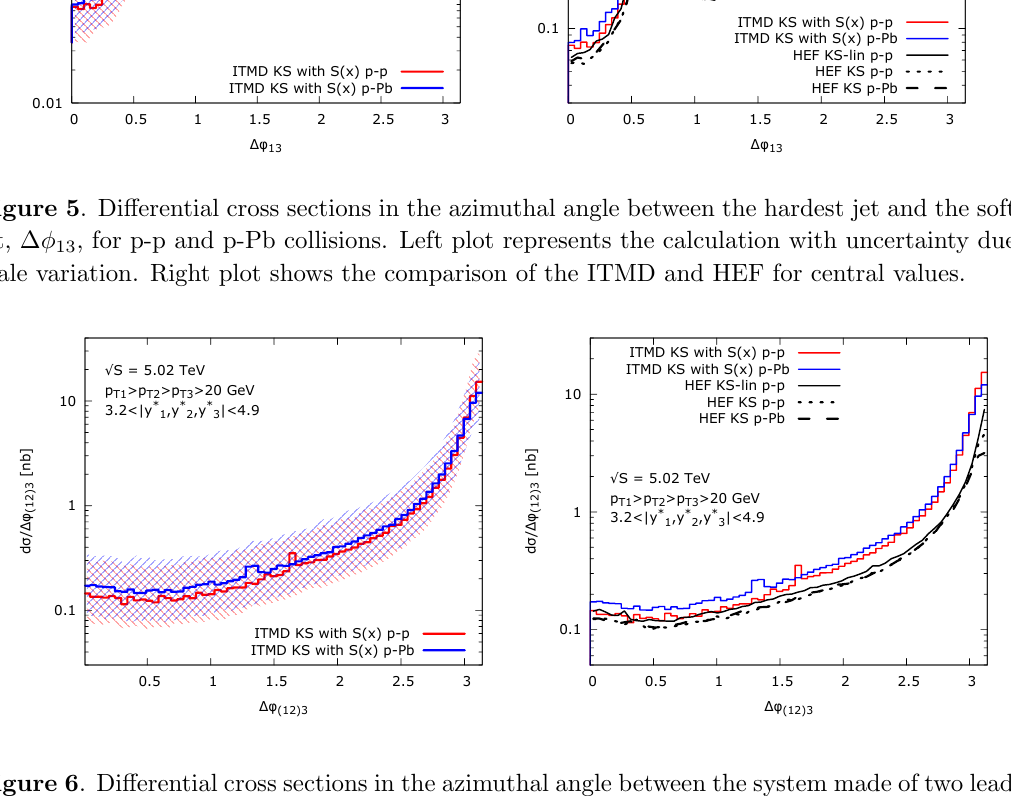
Figure 6 . Di(cid:11)erential cross sections in the azimuthal angle between the system made of two leading jets (12) and the third jet, (cid:1) (cid:30) , for p-p and p-Pb collisions. Top plots represent calculation (12)3 with uncertainty due to scale variation.Left plot represents the calculation with uncertainty due to scale variation. Right plot shows the comparison of the ITMD and HEF for central